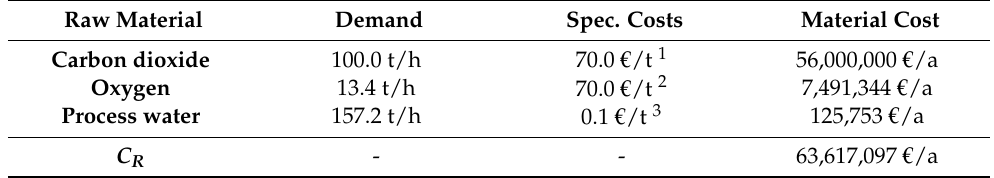
Table 5. Raw material costs for the PtF process.